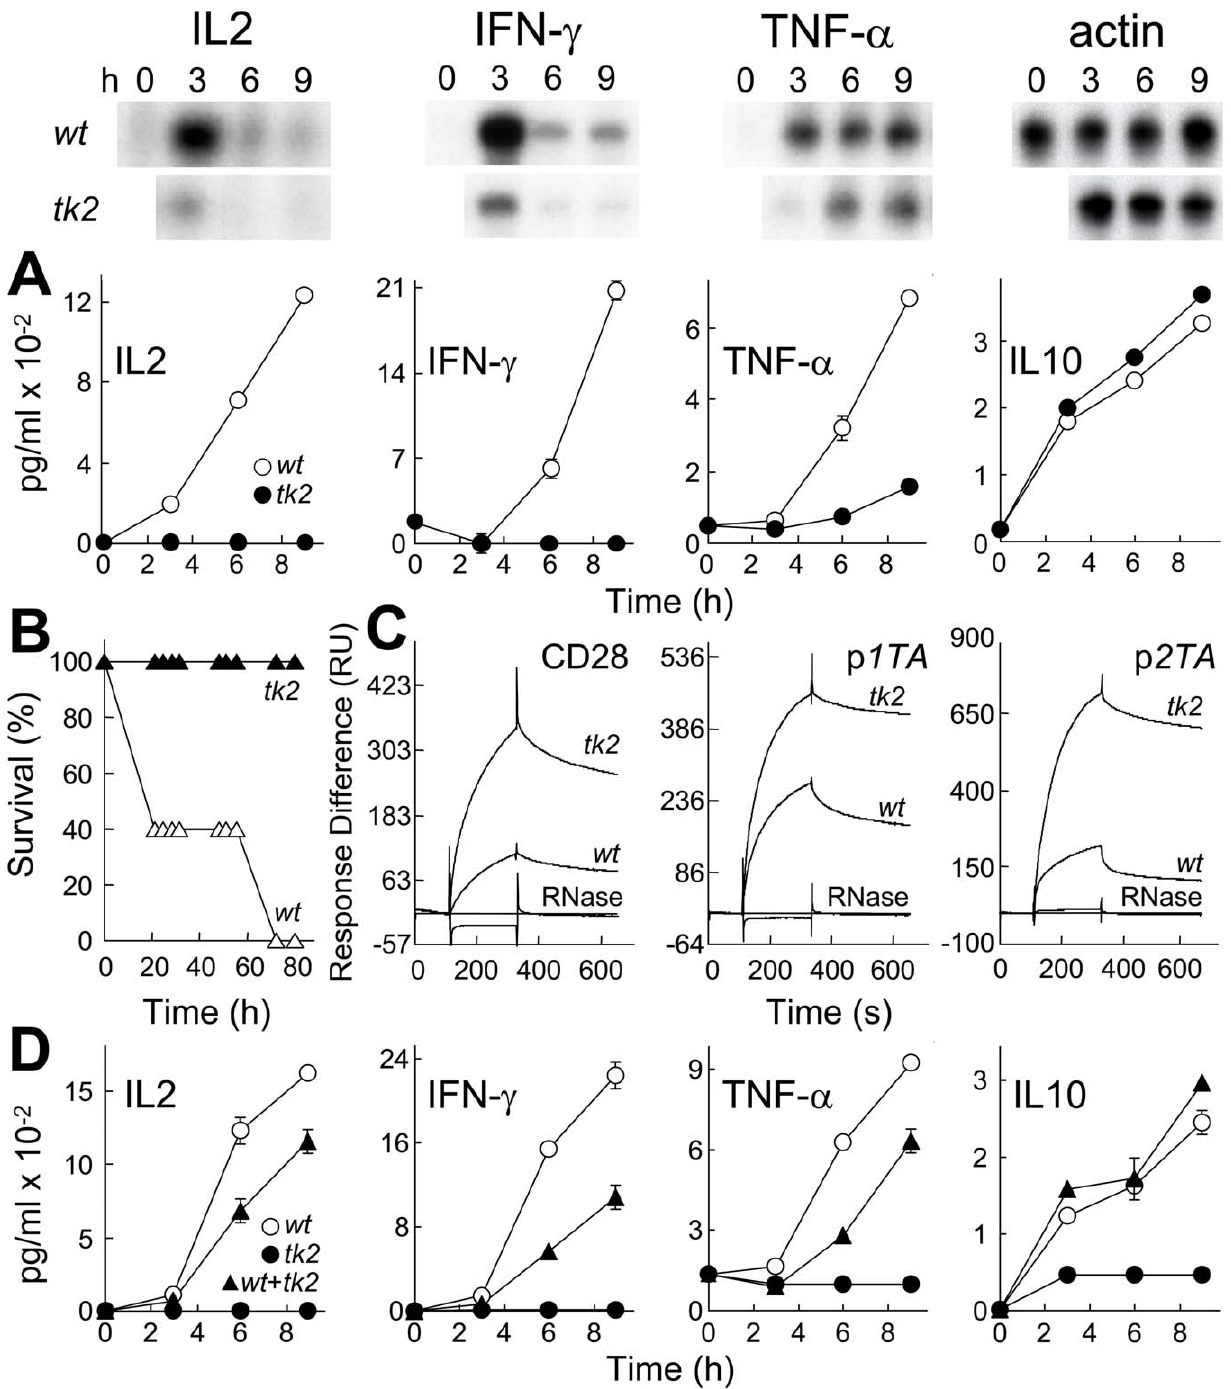
Figure 6. Mutation of SEB b -strand(8)/hinge/ a -helix(4) domain affects binding to CD28, Th1 cytokine gene induction and lethality. (A) Induction of cytokine genes by wt and tk2 mutant SEB. PBMC were induced with 1 ng/ml wt or tk2 SEB; mRNA (autoradiograms) and secreted cytokines (graphs; data are shown as means 6 SEM ( n =3)) are depicted. (B) Lack of lethality of tk2 SEB. Mice ( n =5 per group) were challenged with 10 m g wt or tk2 SEB; p for survival, 10 2 5 . (C) Affinity of tk2 SEB for CD28. Representative SPR responses for binding of wt and tk2 SEB to immobilized CD28-Fc, p 1TA , and p 2TA are shown for 5 m M wt and tk2 SEB or RNase A to facilitate comparison; kinetic data were collected for five 2-fold increments in protein concentration from 1.25 m M (Table S2). (D) Dominant-negative phenotype of tk2 SEB. PBMC were induced with 1 ng/ml wt SEB, 0.1 ng/ml tk2 SEB, or both; secreted cytokines were determined as shown (data are shown as means 6 SEM ( n =3)).